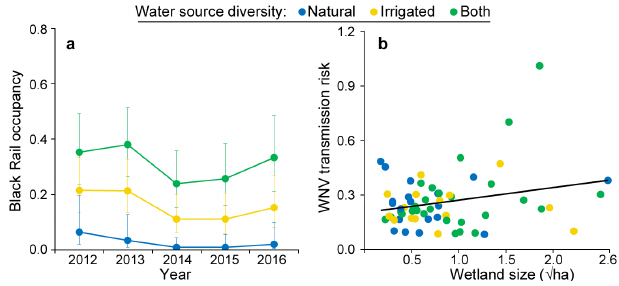
Fig. 5 . Impacts of Sierra Nevada foothills wetlands’ hydrologic diversity on maintenance of ecosystem function during drought. (a) Mean (± 95% CI) probability of occupancy by California Black Rails ( Laterallus jamaicensis coturniculus ) for a median-sized wetland of each water source. (b) West Nile virus (WNV) -infected Culex mosquito abundance increased with wetland size (r² = 0.064, p =